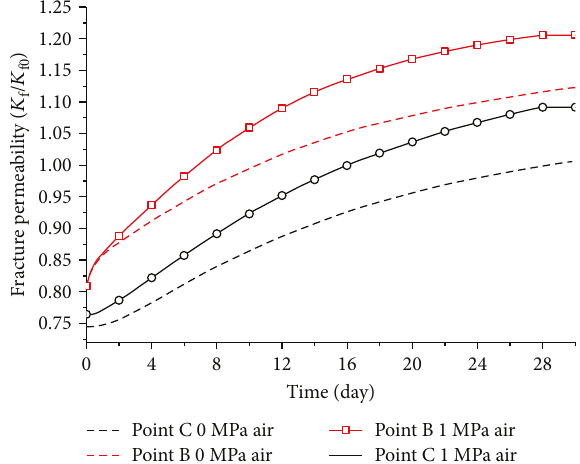
Figure 11: Coal seam permeability change under air